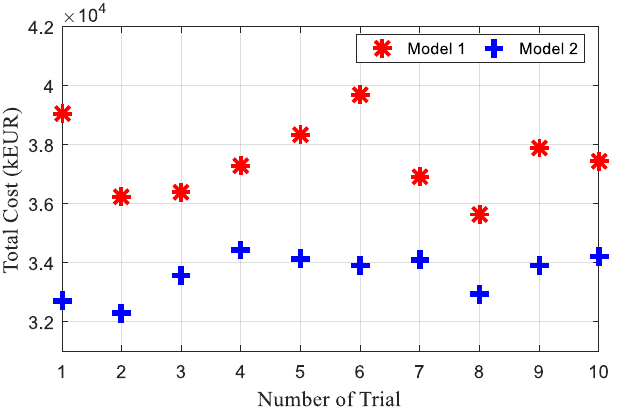
Figure 10. Optimized layout of Model 2 and highlighted the cables which changed the cross-section.